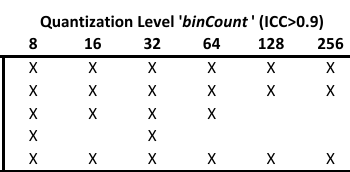
Figure 6. Dependence of the quantization level of NGTDM radiomic features, considering different values (i.e., 8, 16, 32, 64, 128, and 256) of the ‘binCount’ PyRadiomics